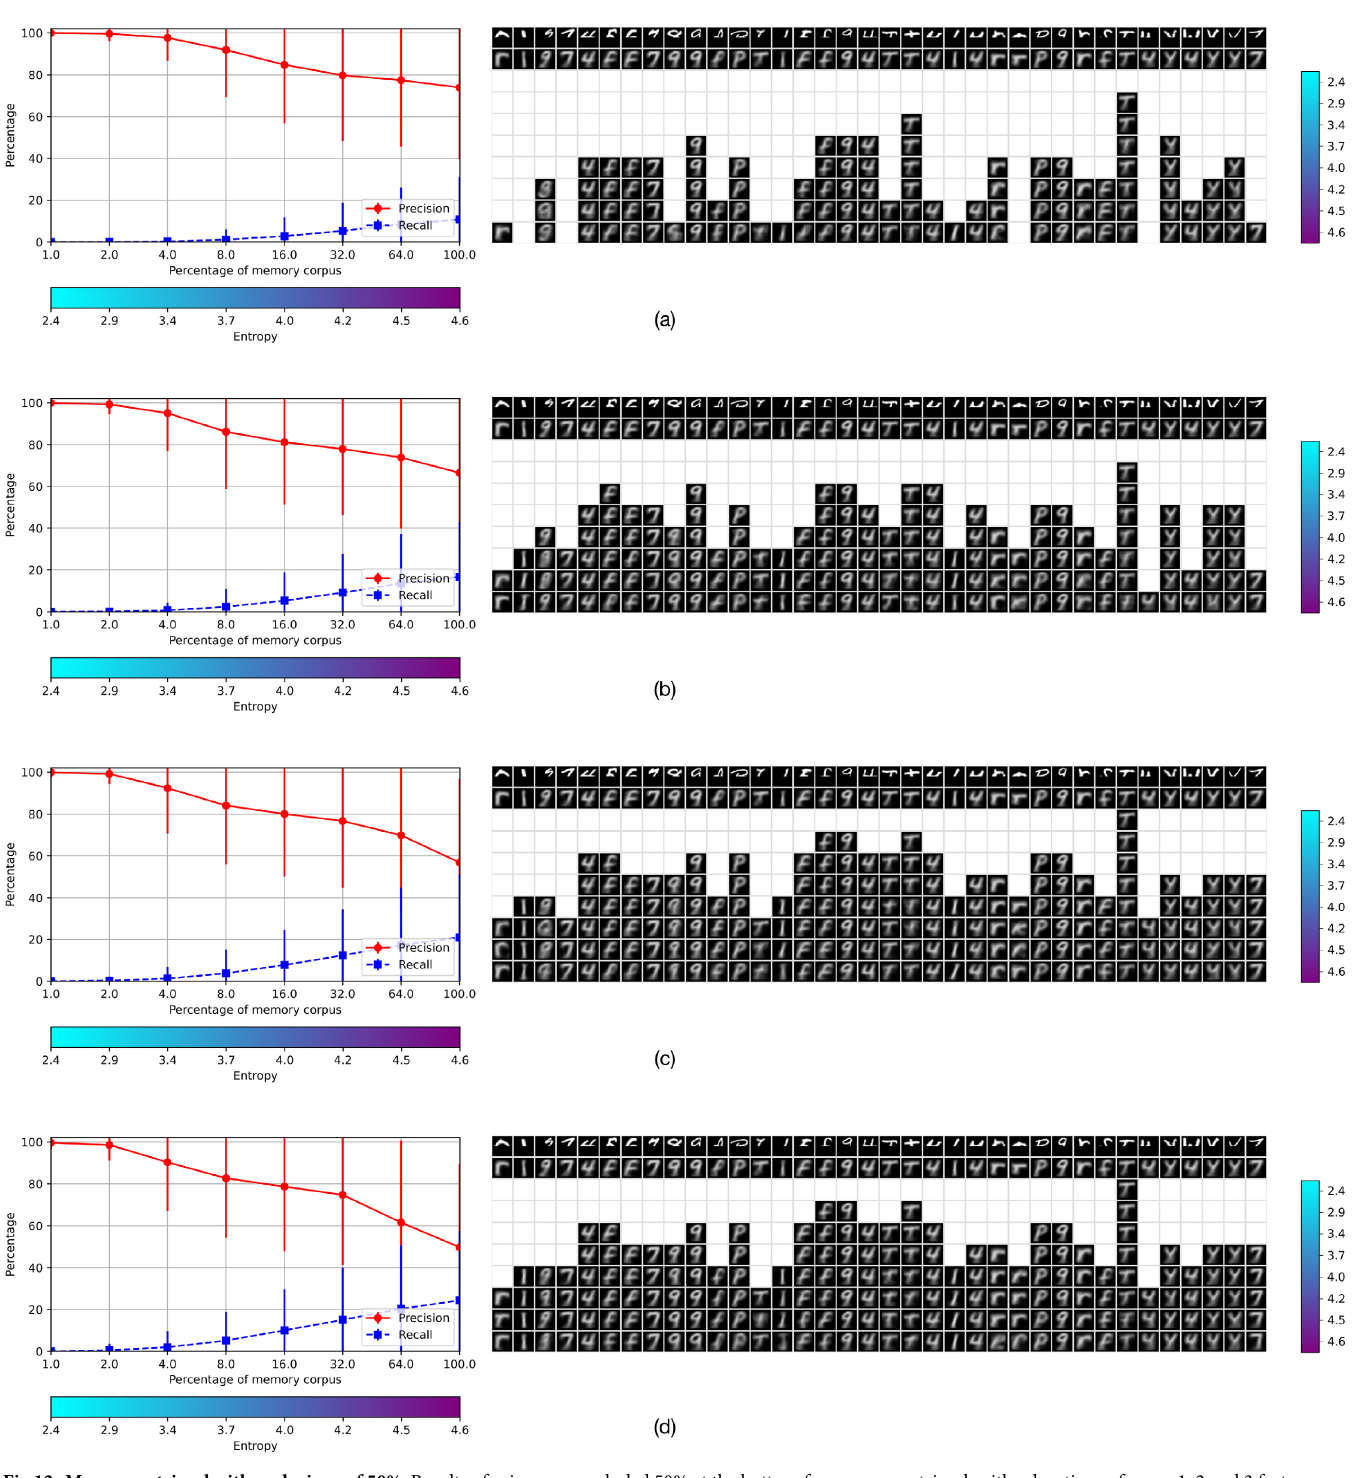
Fig 12. Memory retrieval with occlusions of 50%. Results of using cues occluded 50% at the bottom for memory retrieval, with relaxations of none, 1, 2 and 3 features out of 64.